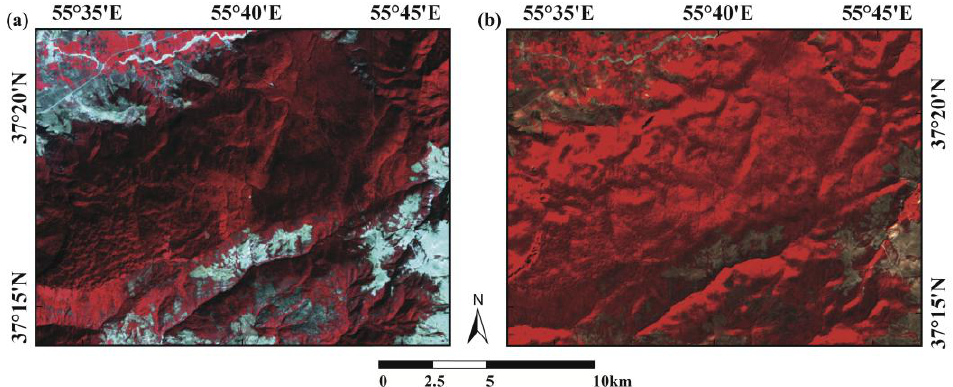
Figure 3. A pseudo-color composite of the Landsat-7/ETM+ (R4:G3:B2) acquired on 10 September 2007 ( a ) before and ( b ) after topographic